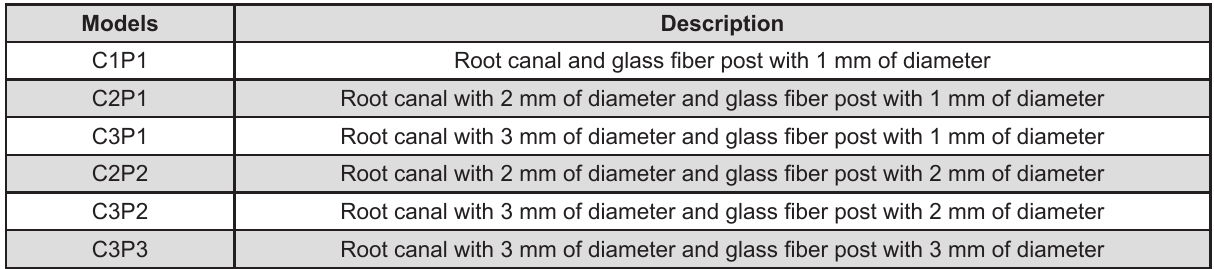
Figure 1- Description of the models with different root canal (C) and glass fiber post (P)